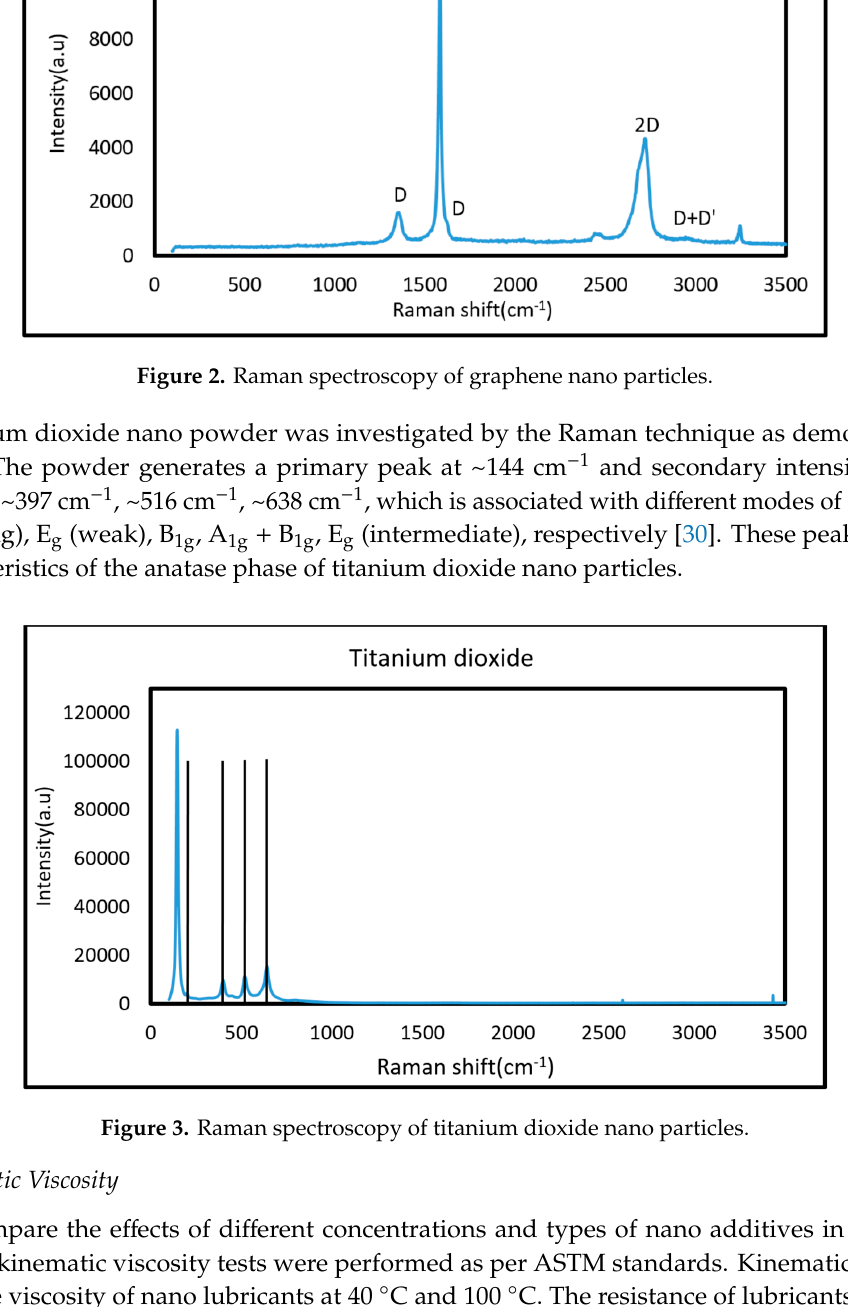
Figure 4. Viscosity index ( A ) and Kinematic viscosity ( B ) of liquid lubricants. 3.4. RPVOT Anti-oxidation capabilities of lubricants were evaluated using the rotating pressure vessel oxidation test (RPVOT) as per ASTM standards. For sustainable improvement, it is important to consider the lubricant’s service life, as lubricants that are not antioxidant can start causing cavitation in the system, which requires changing parts and lubricant. This damages the economic performance of the industry and generates environmental waste. As shown in Figure 5, there is no significant difference in oxidation time using these additives compared to base oil oxidation time. Base oil has shown oxidation time as 27.1 min under the same conditions. This proves that except for S-1, S-3, and S-6, all other samples increase oxidation stability, which allows the lubricant to have a longer service life. Test results conclude that this additive will not damage the economic performance of industries if it is added to the lubricant.